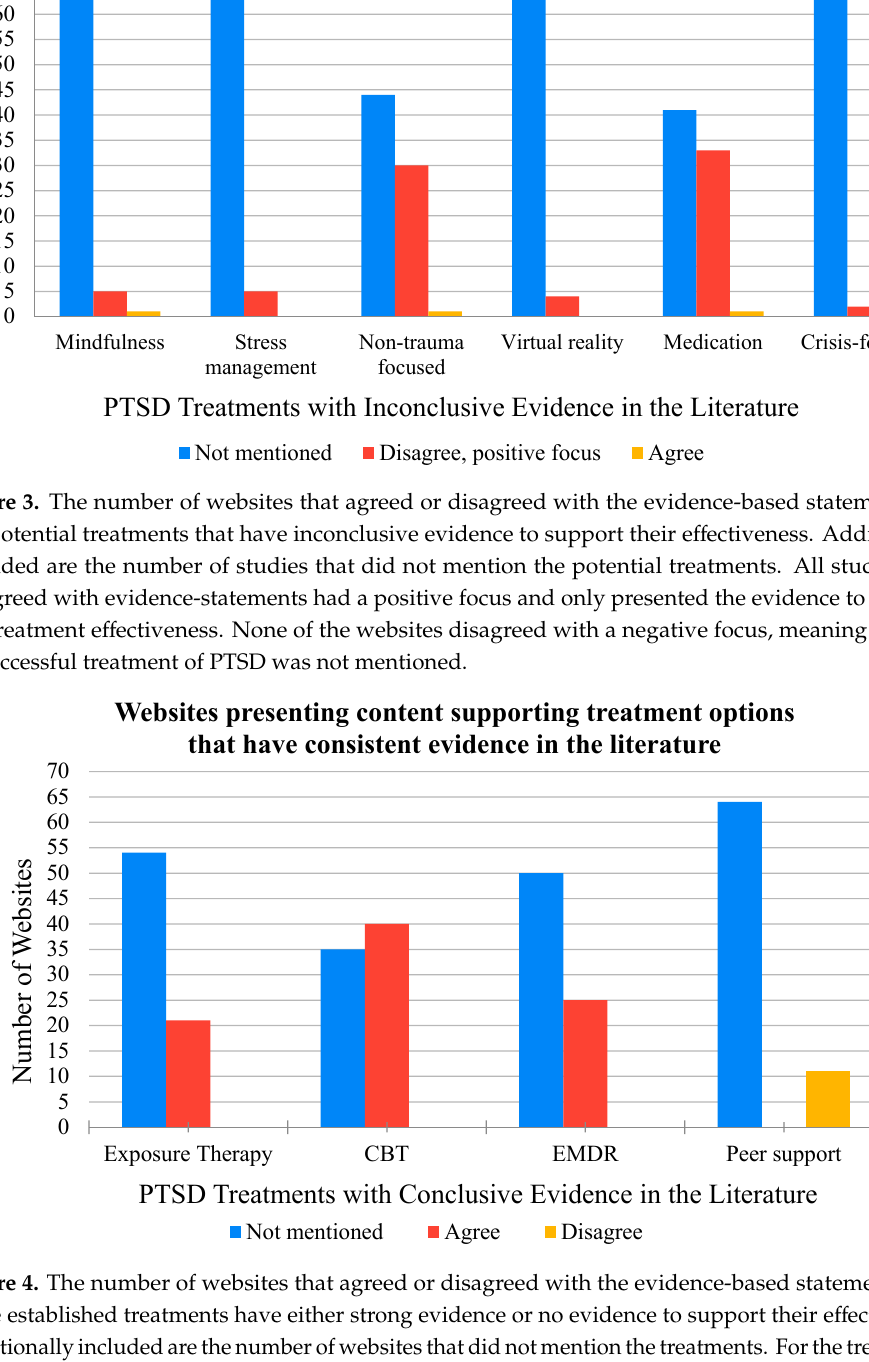
Figure 4. The number of websites that agreed or disagreed with the evidence-based statements that these established treatments have either strong evidence or no evidence to support their effectiveness.